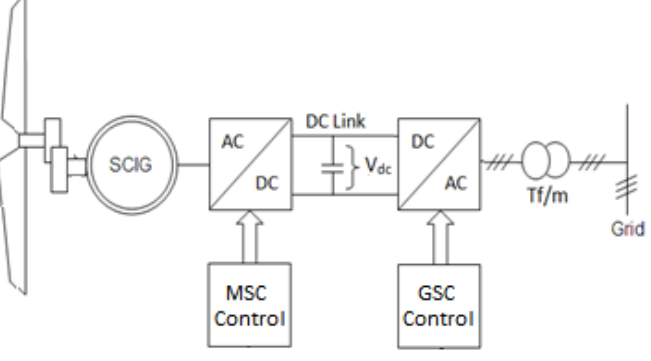
Figure 1. Schematic Diagram of variable speed SCIG-based WECS.